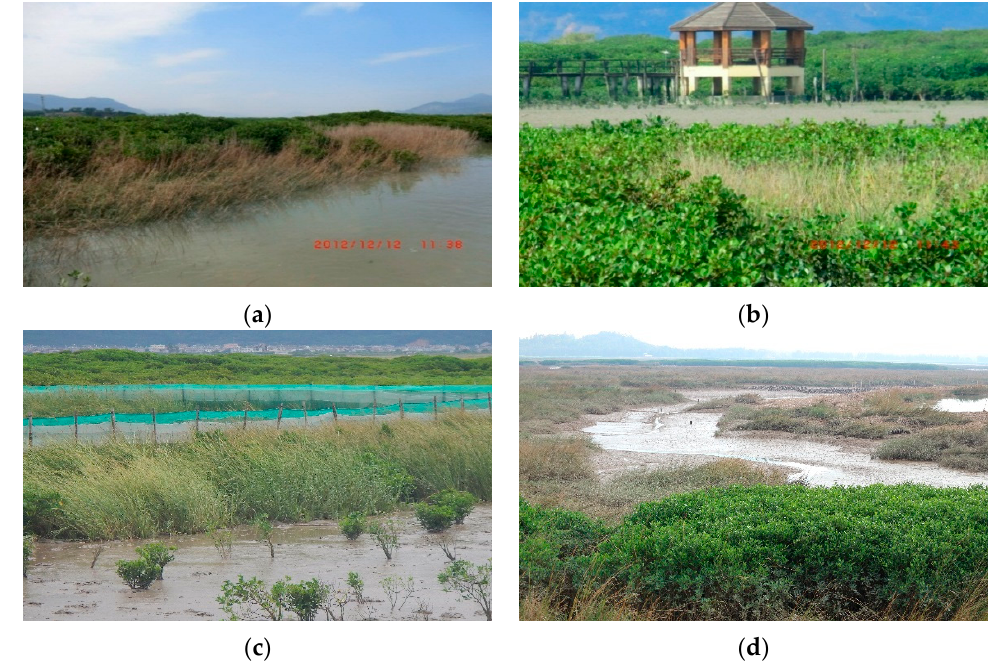
Figure 9. Effects of S. alterniflora invasion in the Zhangjiang Estuary. ( a ) S. alterniflora populations as a strip isolating mangrove from the open sea; ( b ) S. alterniflora growth in the gaps of mangrove forests; ( c ) S. alterniflora invasion as a threat to local mariculture activities; ( d ) S. alterniflora expansion towards to the